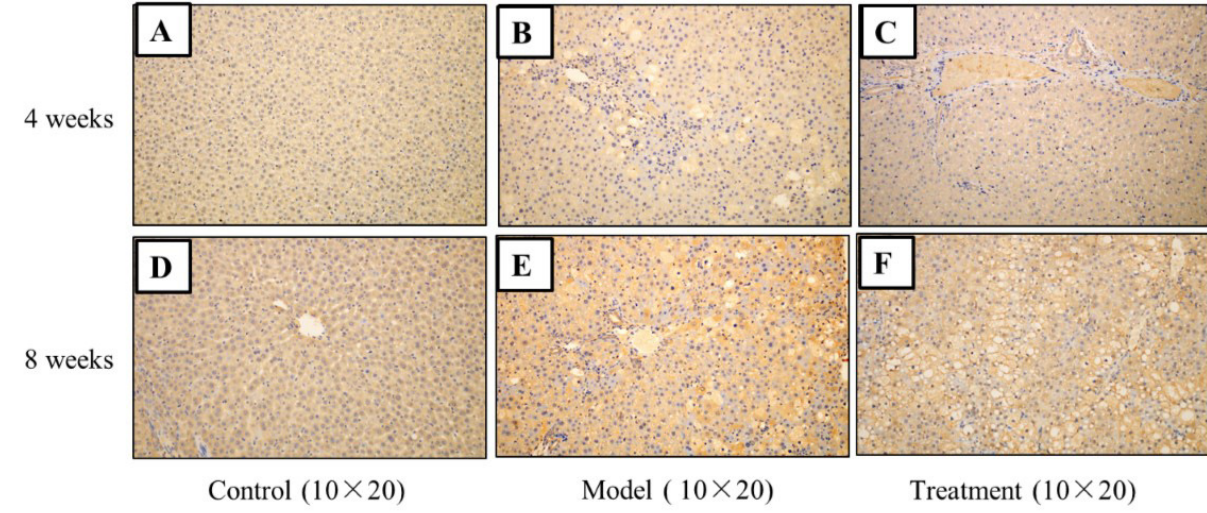
-induced group, and DHZCP-treated group at 4